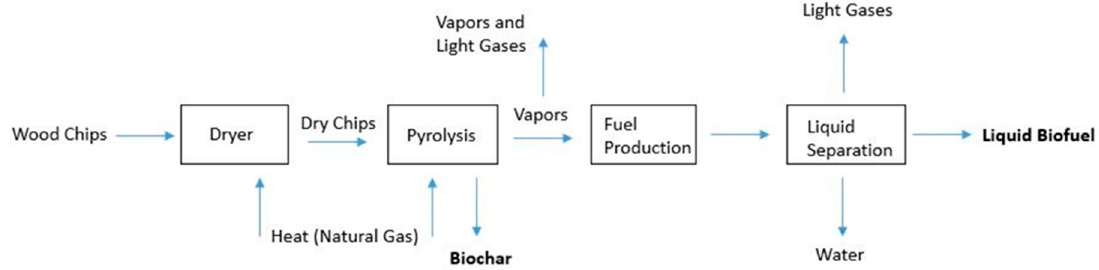
Figure 2. Schematic diagram of liquid biofuels production via pyrolysis with biochar co-product.